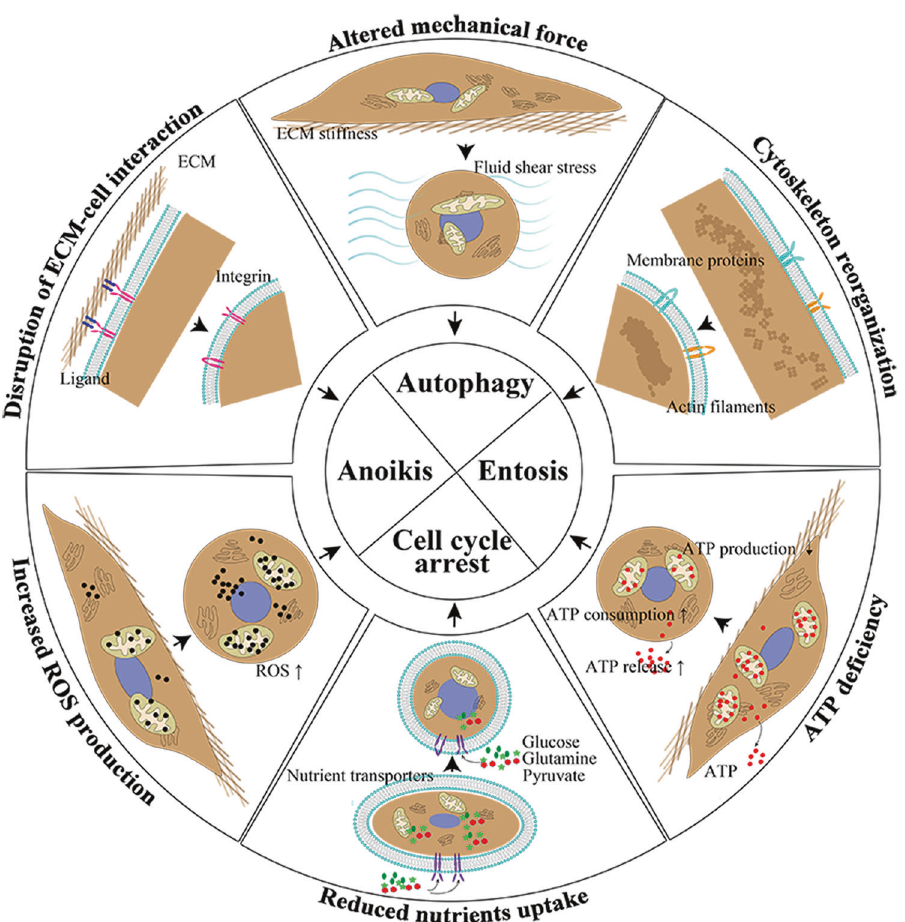
Fig. 1 The anchorage-independent survival and cellular and environmental changes during detachment. After losing anchorage to ECM, the cells are exposed to a totally different environment and present multiple cellular changes, including disruption of extracellular matrix (ECM) – cell interaction, altered mechanical force, cytoskeleton reorganization, ATP de fi ciency, reduced nutrient uptake, and increased reactive oxygen species (ROS) production. A Disruption of extracellular matrix (ECM) – cell interaction. Integrins lose the binding of ligands and stimulation from the ECM. B Altered mechanical force. The main mechanical force shifts from ECM stiffness to fl uid shear stress. C Cytoskeleton reorganization. The cells present a round cell morphology and the membrane proteins undergo structure deformation and activation. D ATP de fi ciency. ATP de fi ciency is a result of reduced ATP production, increased ATP release, and enhanced ATP consumption. E Reduced nutrient uptake. The uptake of glucose, glutamine, and pyruvate is reduced in detached cells due to various reasons. F Increased ROS production. The ROS generation is increased during detachment. As a result, the detached cells undergo anoikis, autophagy, entosis, and cell cycle